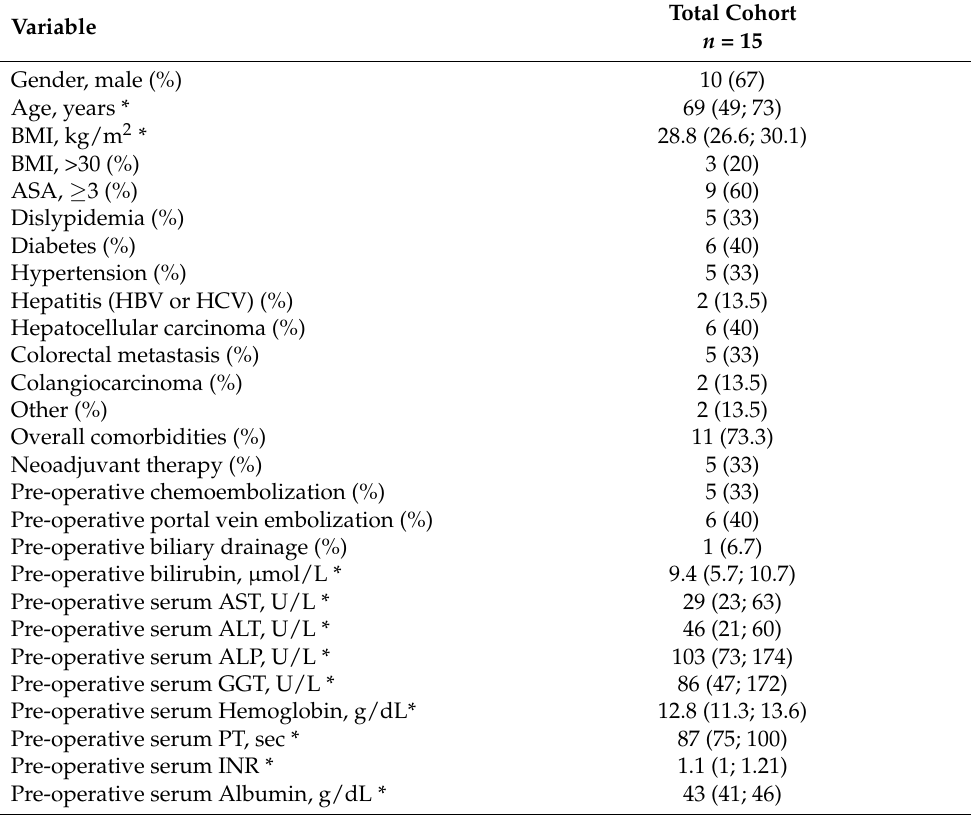
Table 1. Descriptive analysis of pre-operative